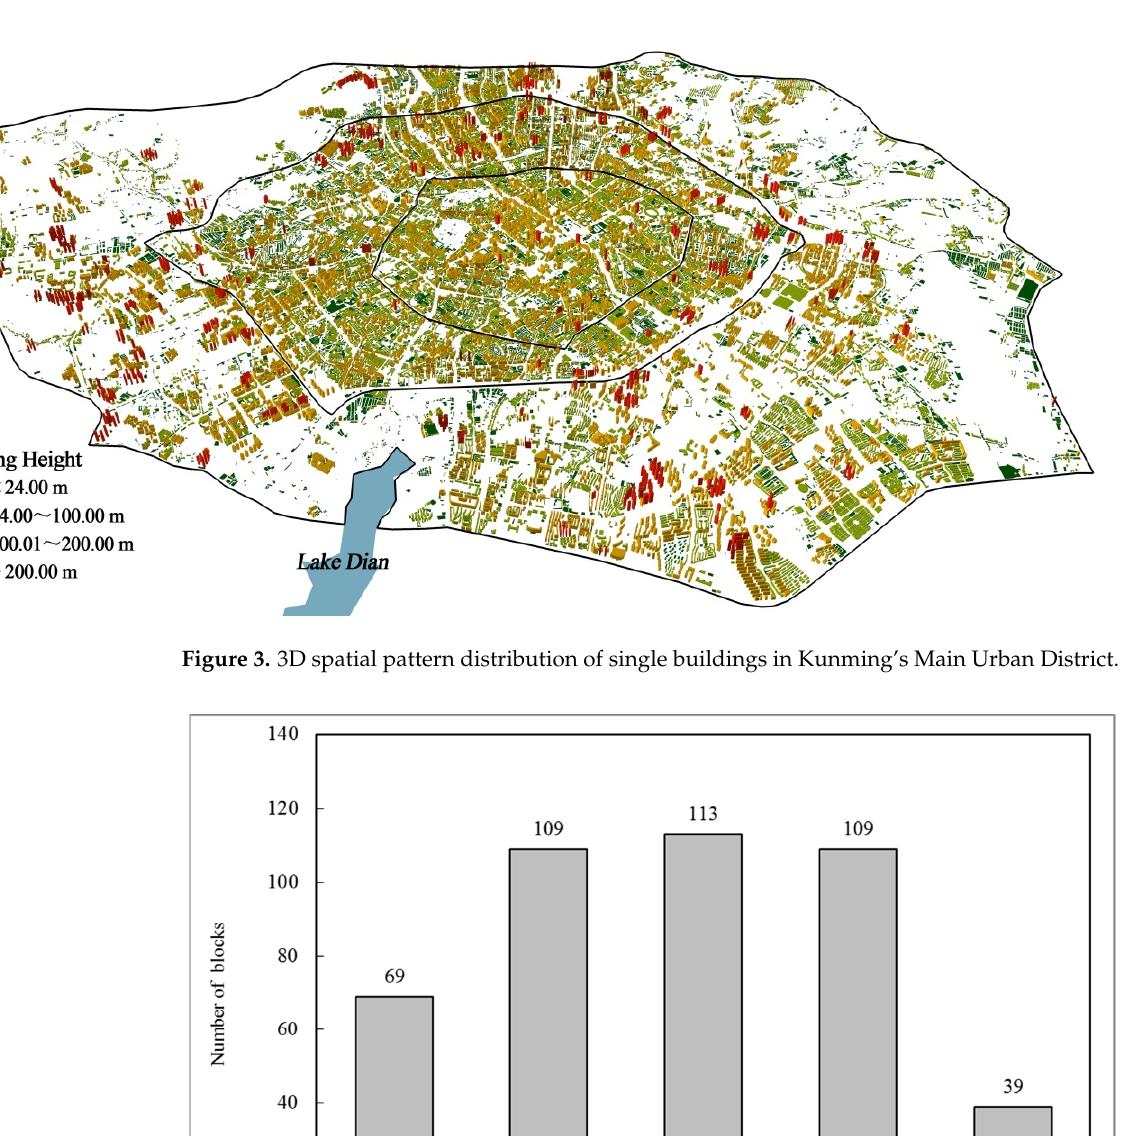
Figure 3. 3D spatial pattern distribution of single buildings in Kunming’s Main Urban District.